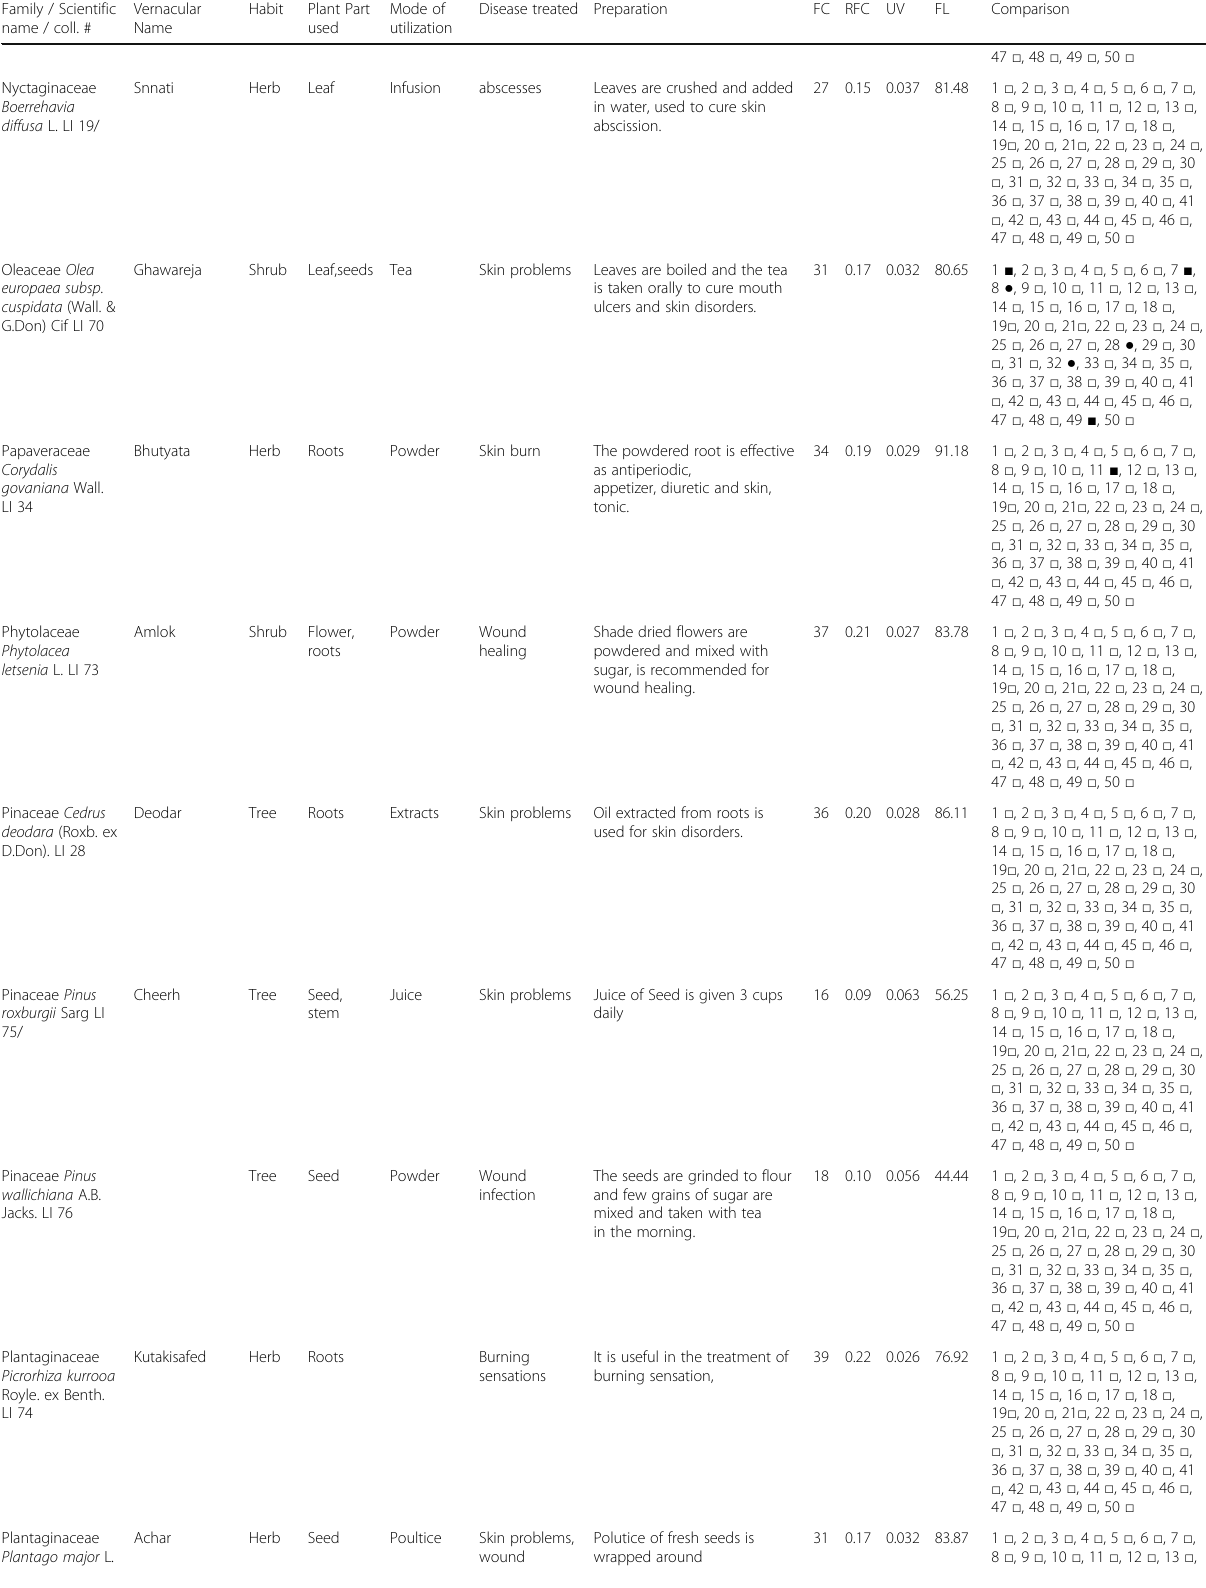
Table 2 Medicinal plants used for skin diseases in Northern Pakistan (Continued) Family / Scientific name / coll.